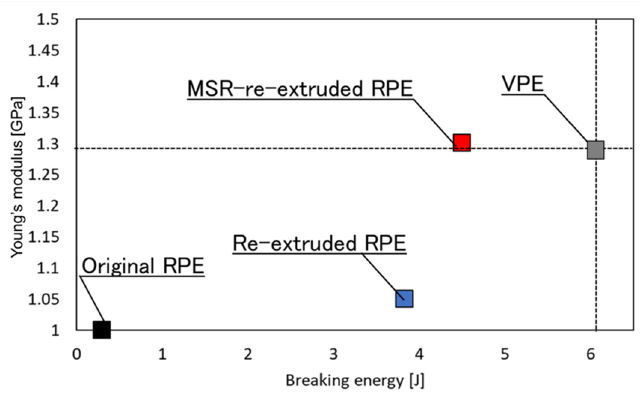
Figure 10. Relationship between the Young’s moduli and breaking energies of the original recycled polyethylene (RPE, black), re-extruded RPE (blue), molten resin reservoir (MSR)-re-extruded RPE (red), and virgin PE (VPE, grey).